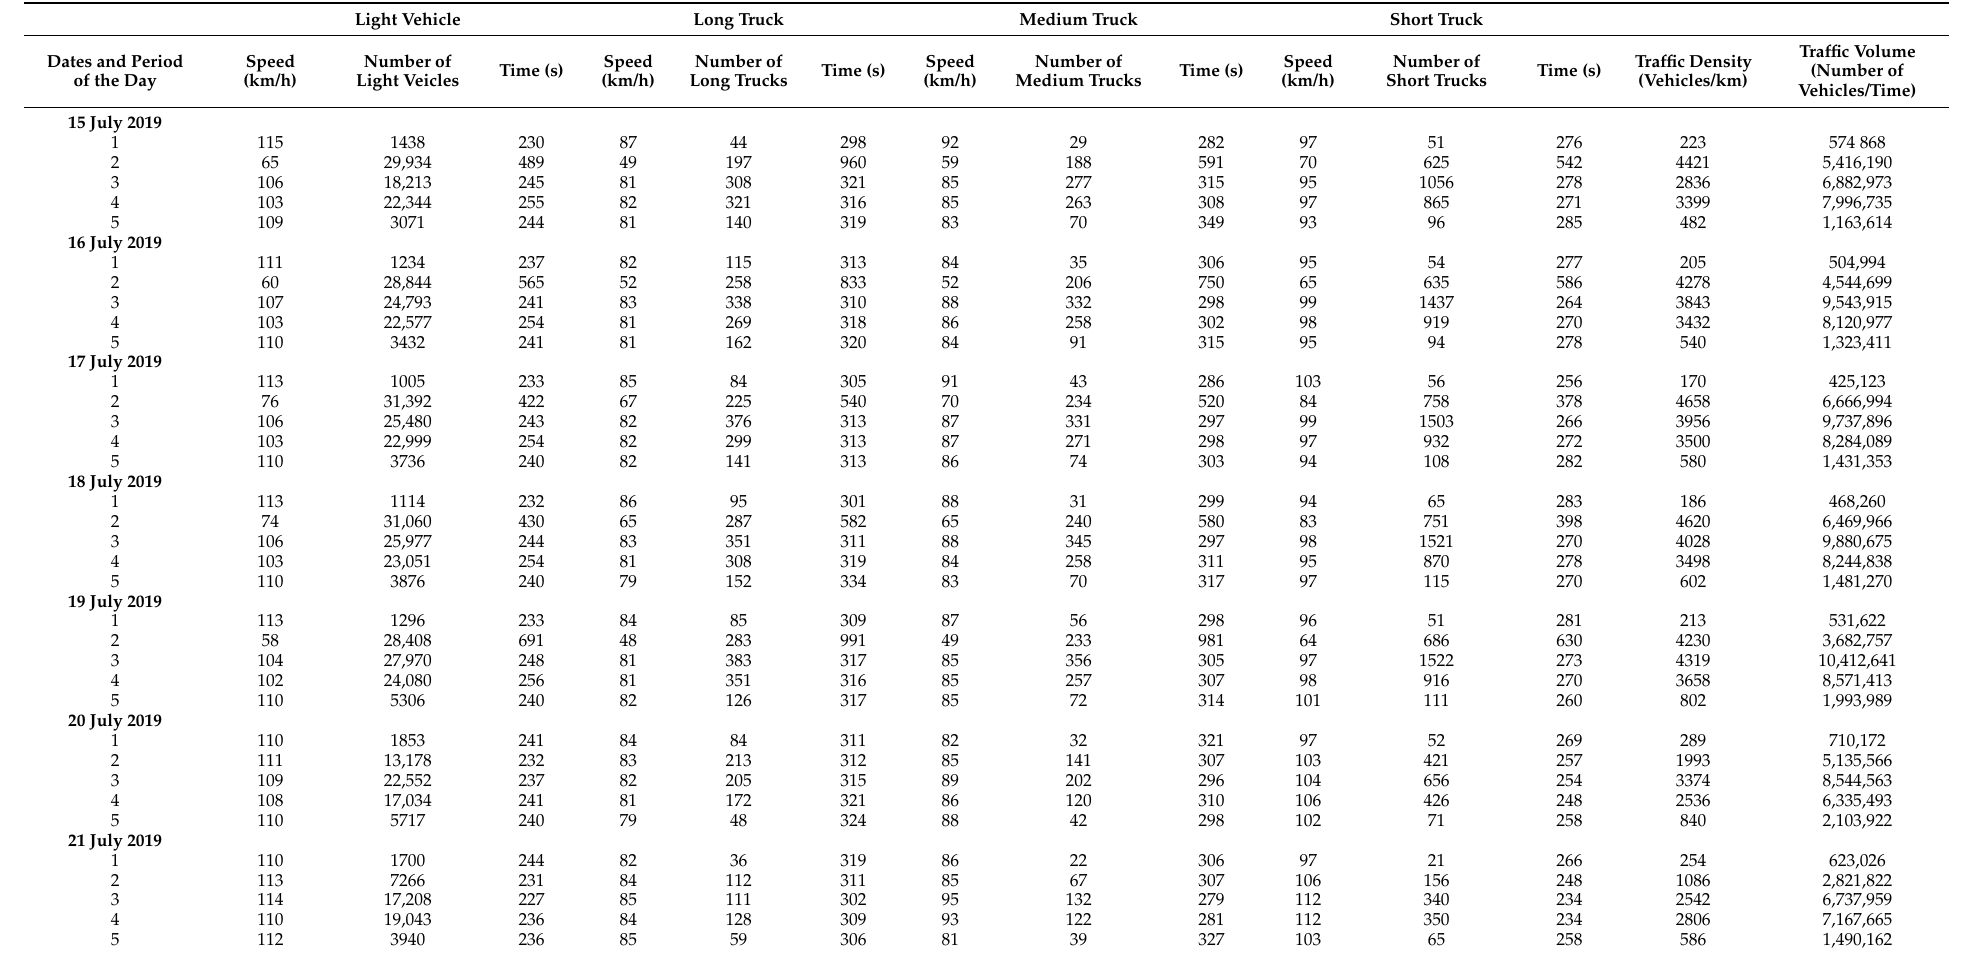
Table A2. Sample of Vehicular Traffic flow datasets used for the